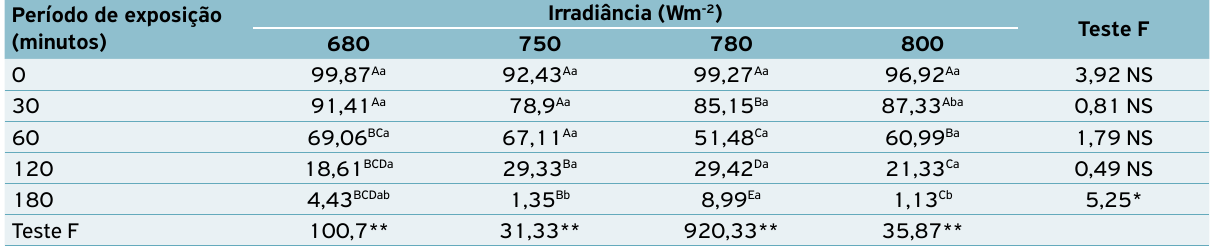
Tabela 1. Germinação (%) de conídios do isolado de Metarhizium anisopliae expostos à radiação proveniente de um simulador solar em diferentes períodos e